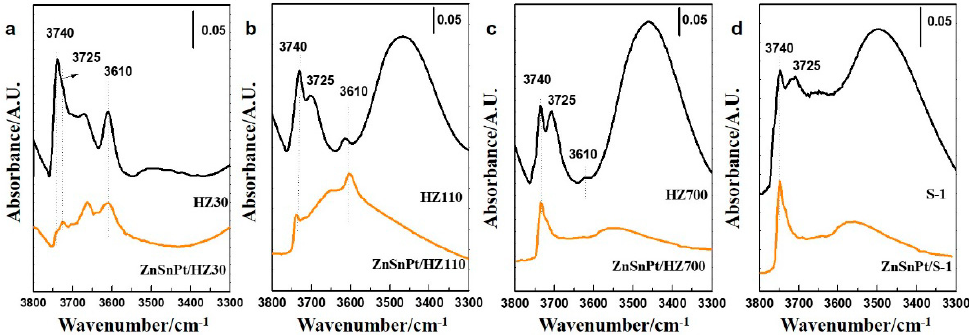
Figure 5. OH-FT-IR spectra of parent and Zn–Sn-Pt modified defective MFI zeolites with different SiO 2 /Al 2 O 3 ratios. ( a ) HZ30 and ZnSnPt/HZ30; ( b ) HZ110 and ZnSnPt/HZ110; ( c ) HZ700; ZnSnPt/HZ700; ( d ) S-1 and ZnSnPt/S-1.